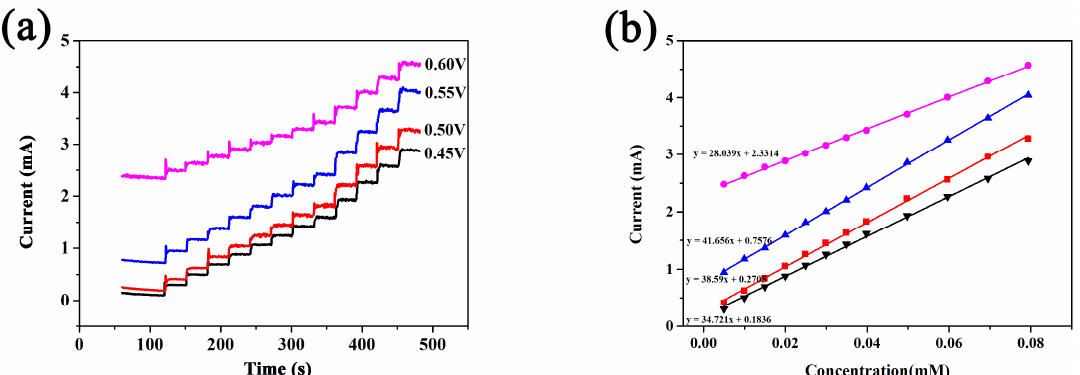
Figure 6. ( a ) Amperometric response with successive addition of 10 mM glucose at different potentials. ( b ) The corresponding calibration curve for glucose oxidation.